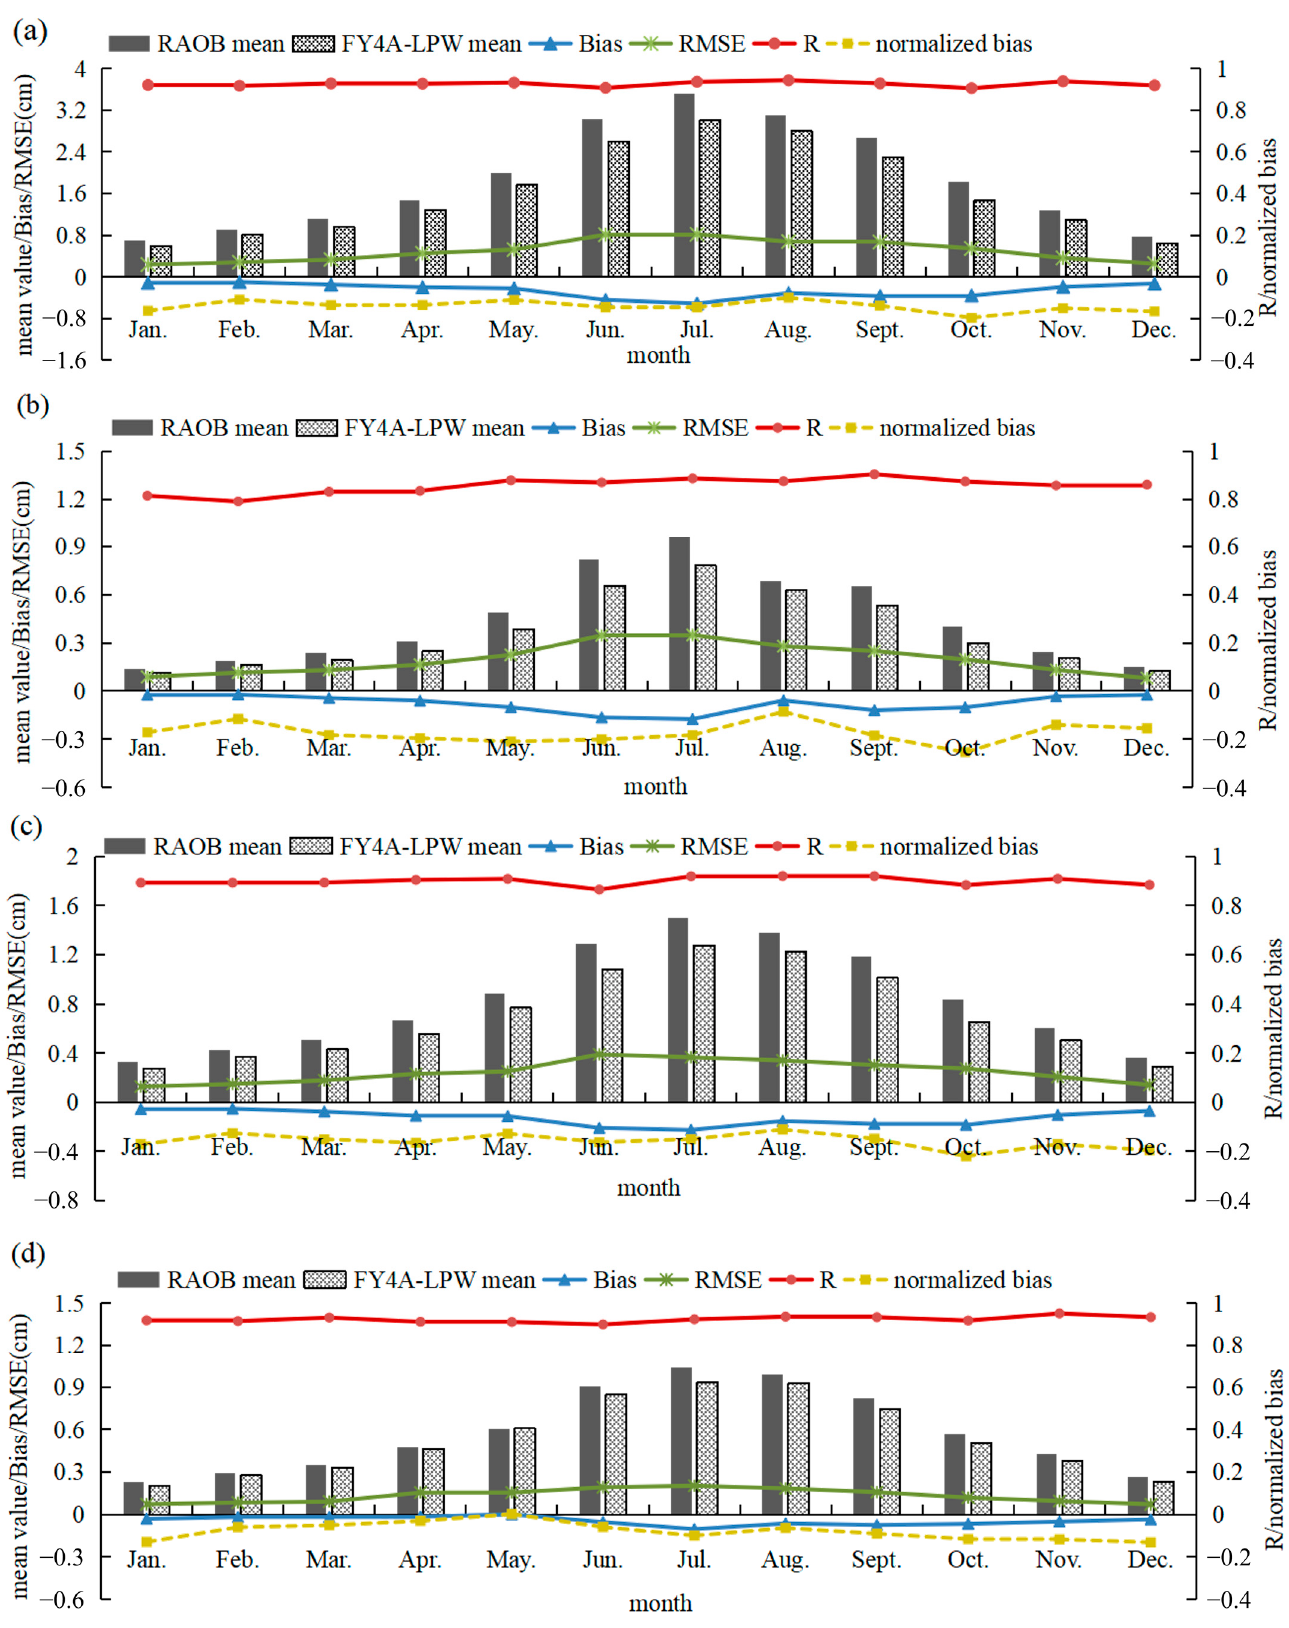
Figure 4. Monthly time series of the Bias and RMSE. ( a ) Whole layer; ( b ) high layer; ( c ) middle layer; ( d ) low layer.